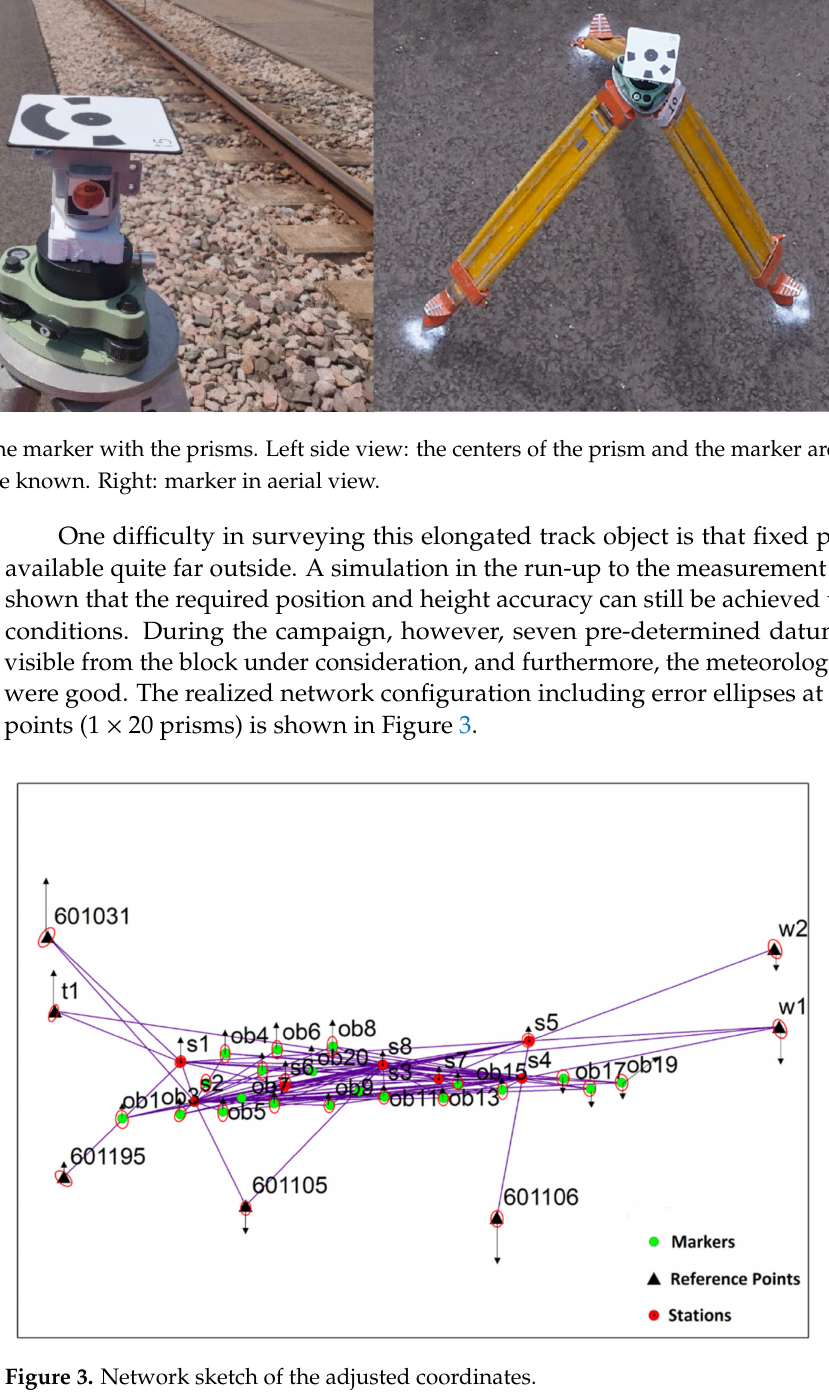
Figure 3. Network sketch of the adjusted